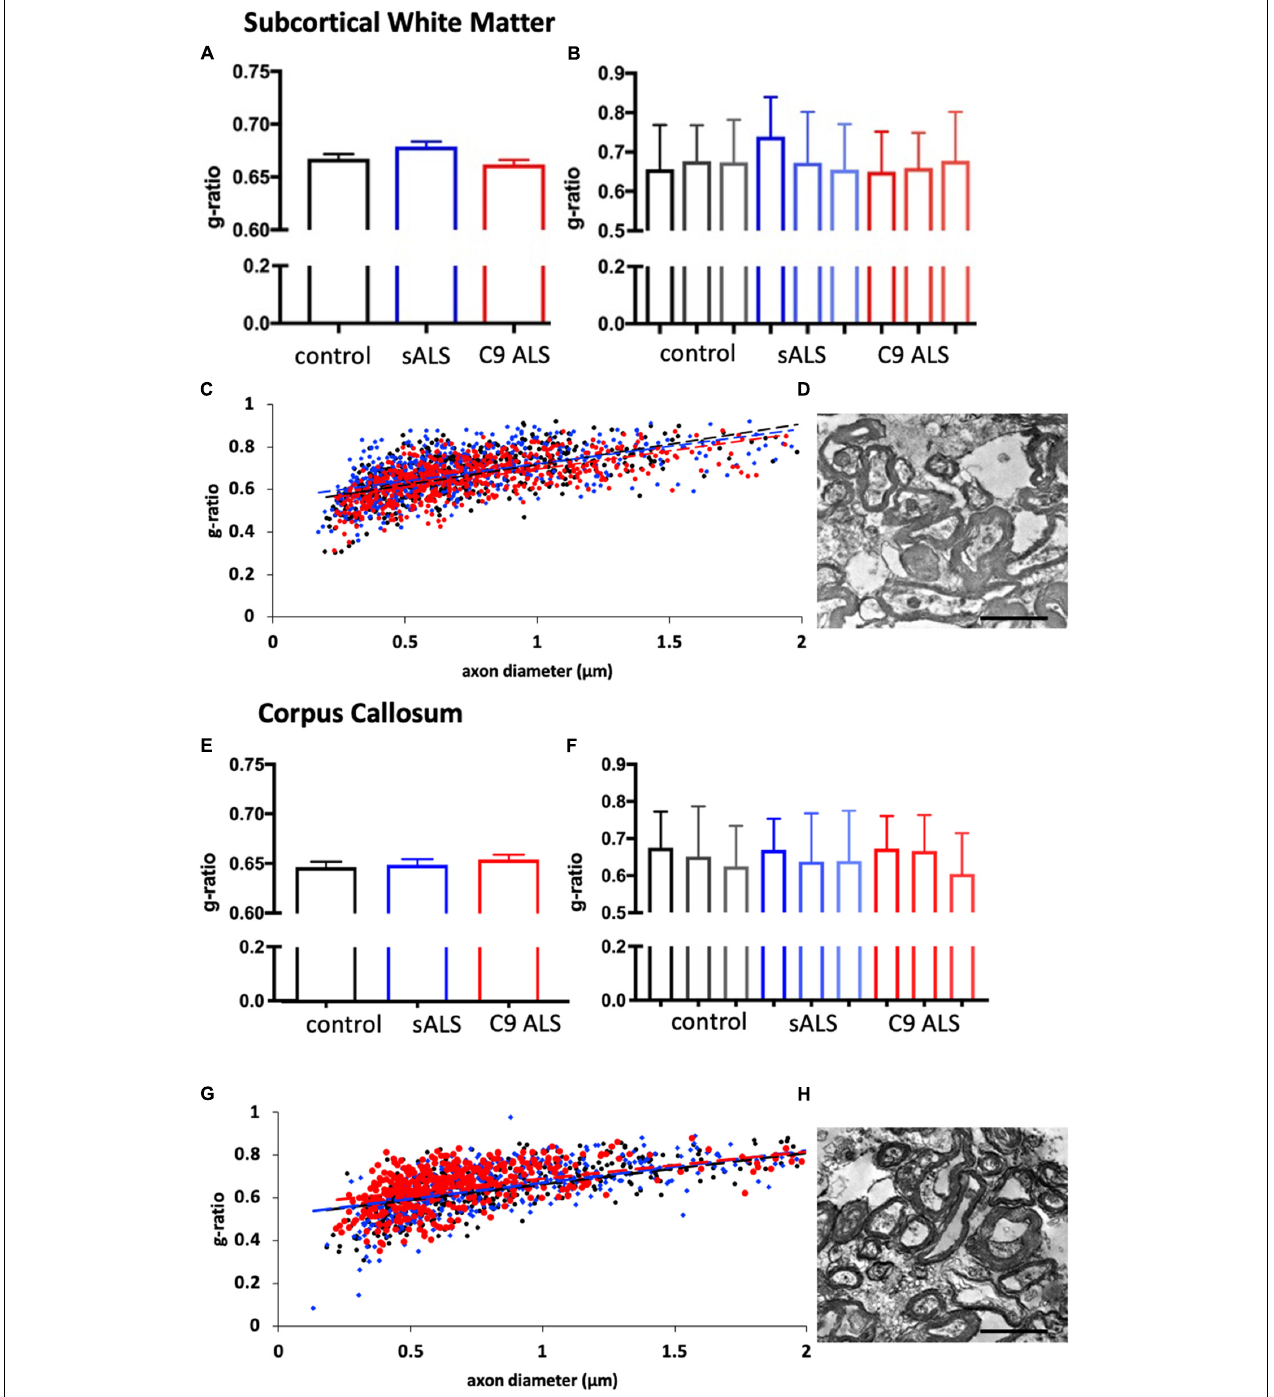
FIGURE 3 | Myelin thickness is not altered in ALS patients. (A) Graph showing the g-ratio calculated for sALS and C9orf72 ALS patients and compared to control patients in the BA6/8 subcortical white matter showing no difference between cases; n = 3 for each genotype. (B) Graph showing the g-ratios for each individual sALS and C9orf72 ALS patient compared to controls in the BA6/8 subcortical white matter. (C) Graph showing g-ratio respective to axon diameter for control patients (black), sALS patients (blue) and C9orf72 patients (red) in the BA6/8 subcortical white matter. (D) Representative electron micrograph from the motor cortex white matter of a C9 ALS patient. (E) Graph showing the g-ratio calculated for sALS and C9orf72 ALS patients and compared to control patients in the corpus callosum showing no difference between cases; n = 3 for each genotype. (F) Graph showing the g-ratios for each individual sALS and C9orf72 ALS patient compared to controls in the corpus callosum. (G) Graph showing g-ratio respective to axon diameter for control patients (black), sALS patients (blue) and C9orf72 patients (red) in the corpus callosum. (H) Representative electron micrograph from corpus callosum of a C9 ALS patient Scale bar = 7 µ m.